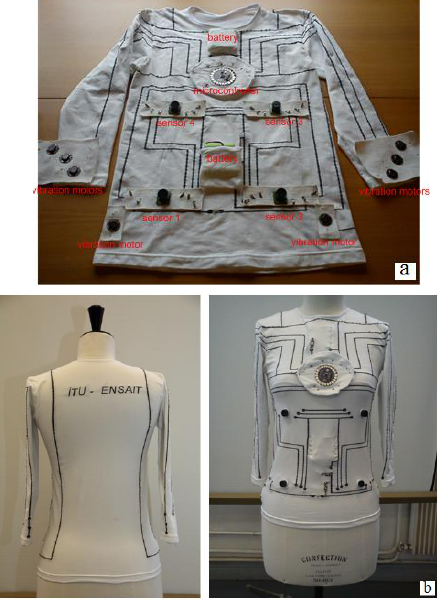
Fig.1. Developed interactive garment 3. Navigation problem of visually impaired people 3.1 Kinematics analysis of walking